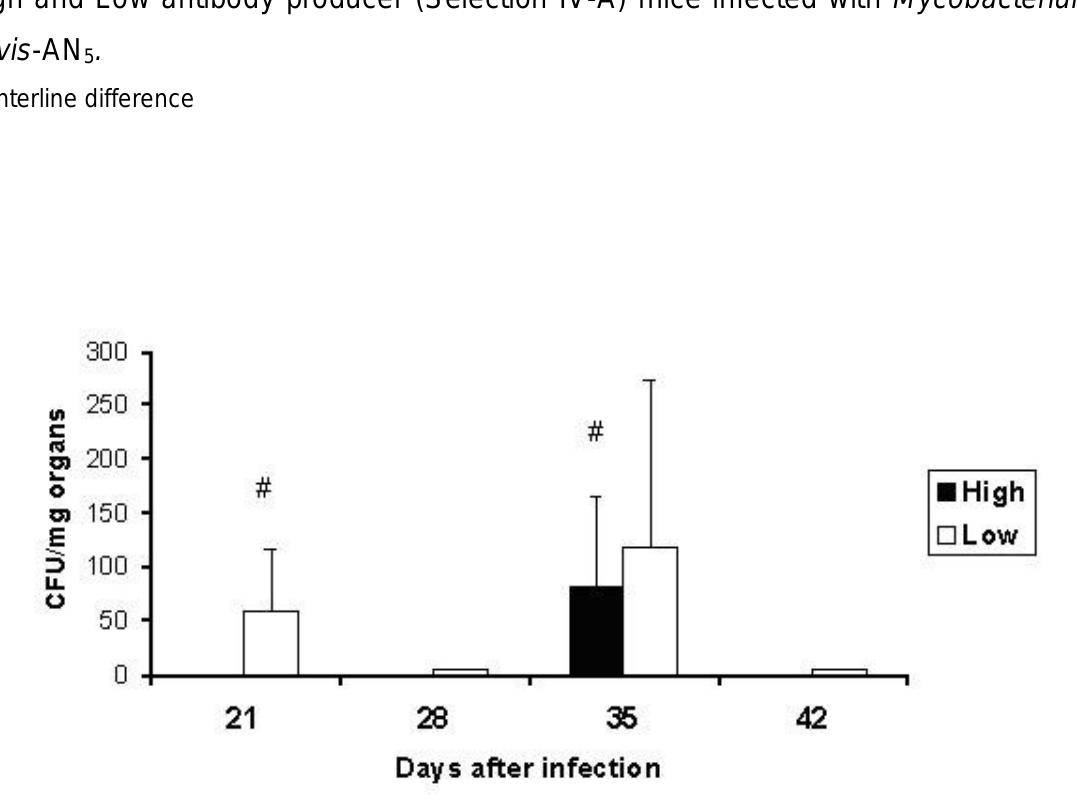
Figure 2. Recovery of viable bacteria (CFU/mg organs) from splenic fragments of High and Low antibody producer (Selection IV-A) mice infected with Mycobacterium bovis -AN 5